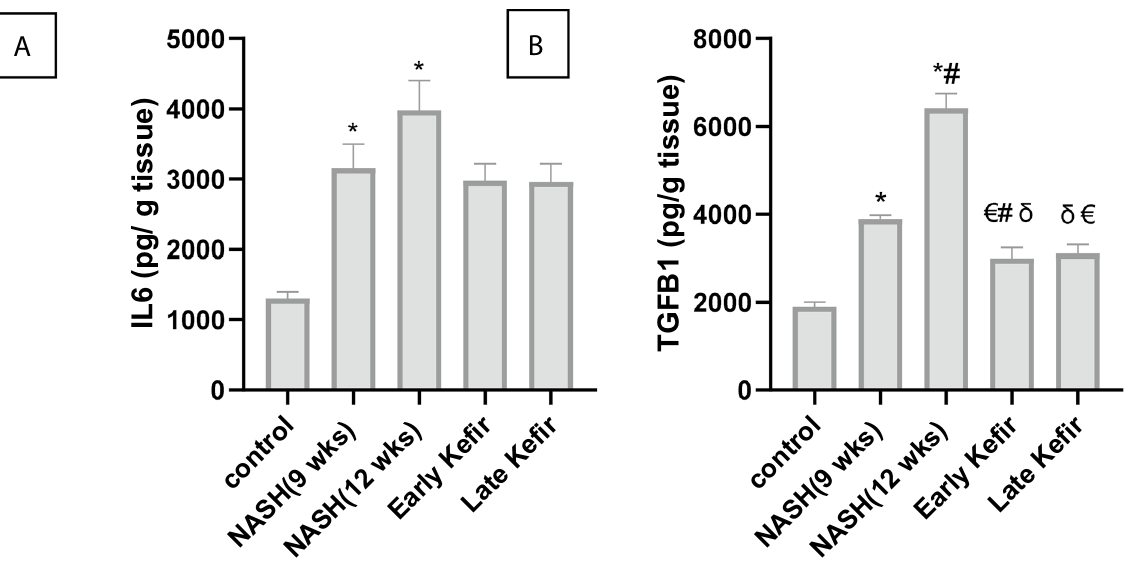
Figure 6. The effect of Kefir treatment on ( A ) Level of IL-6 ( B ) Level of TGF-β1 in liver tissues from various groups. Values are mean ± SEM, number of animals = 8 rats/each group. *P < 0.001 compared to control group, # P < 0.001 compared to NASH (9 weeks) group, δ P < 0.001 compared to NASH (12 weeks) group, € P < 0.05 compared to control group. One-way ANOVA followed by Tukey’s multiple comparison test. IL6 Interleukin 6, TGFB1 transforming growth factor beta